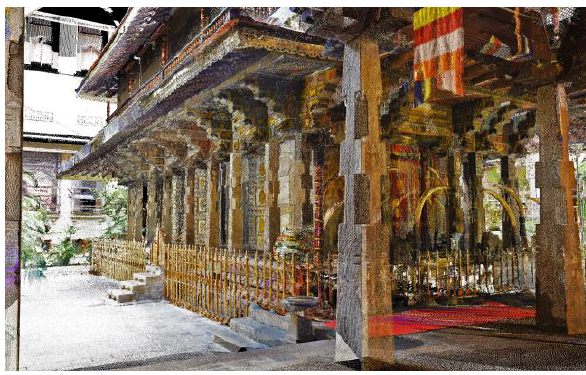
Fig. 9. Point cloud rendering of shrine and